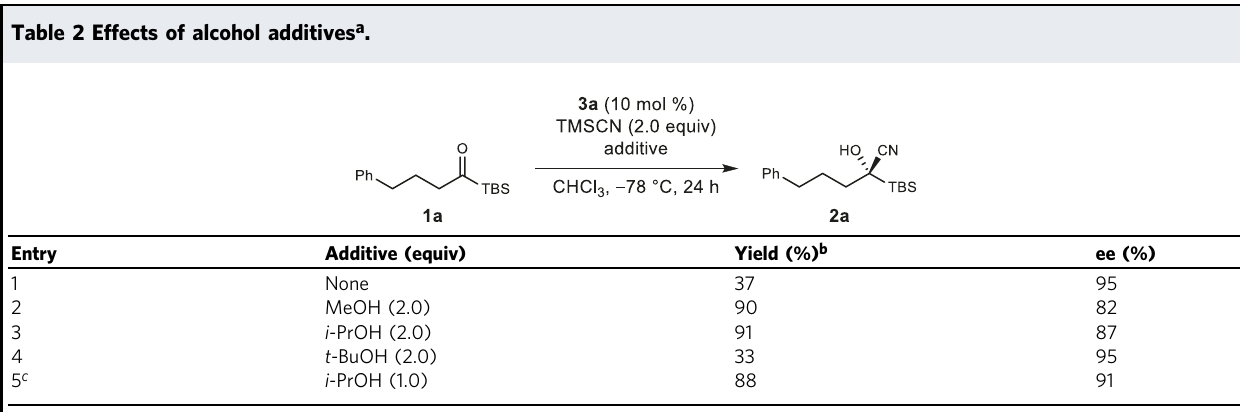
Table 2 Effects of alcohol additives a